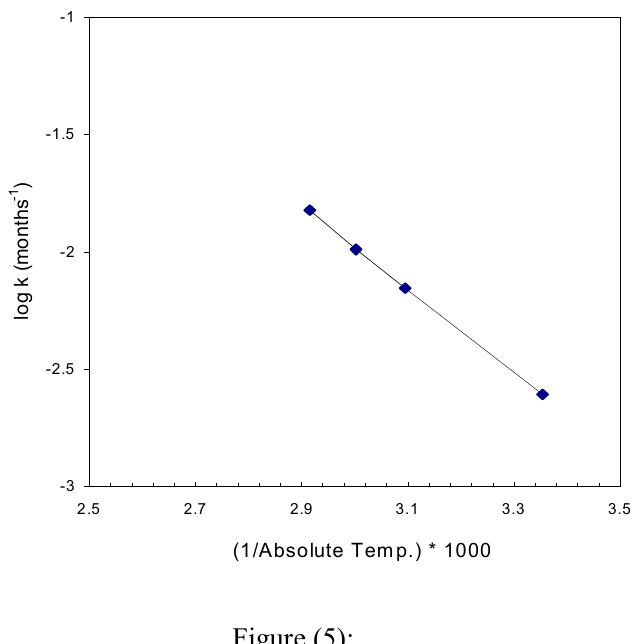
Arrhenius plot for a shelf – life estimation of captopril using (formula